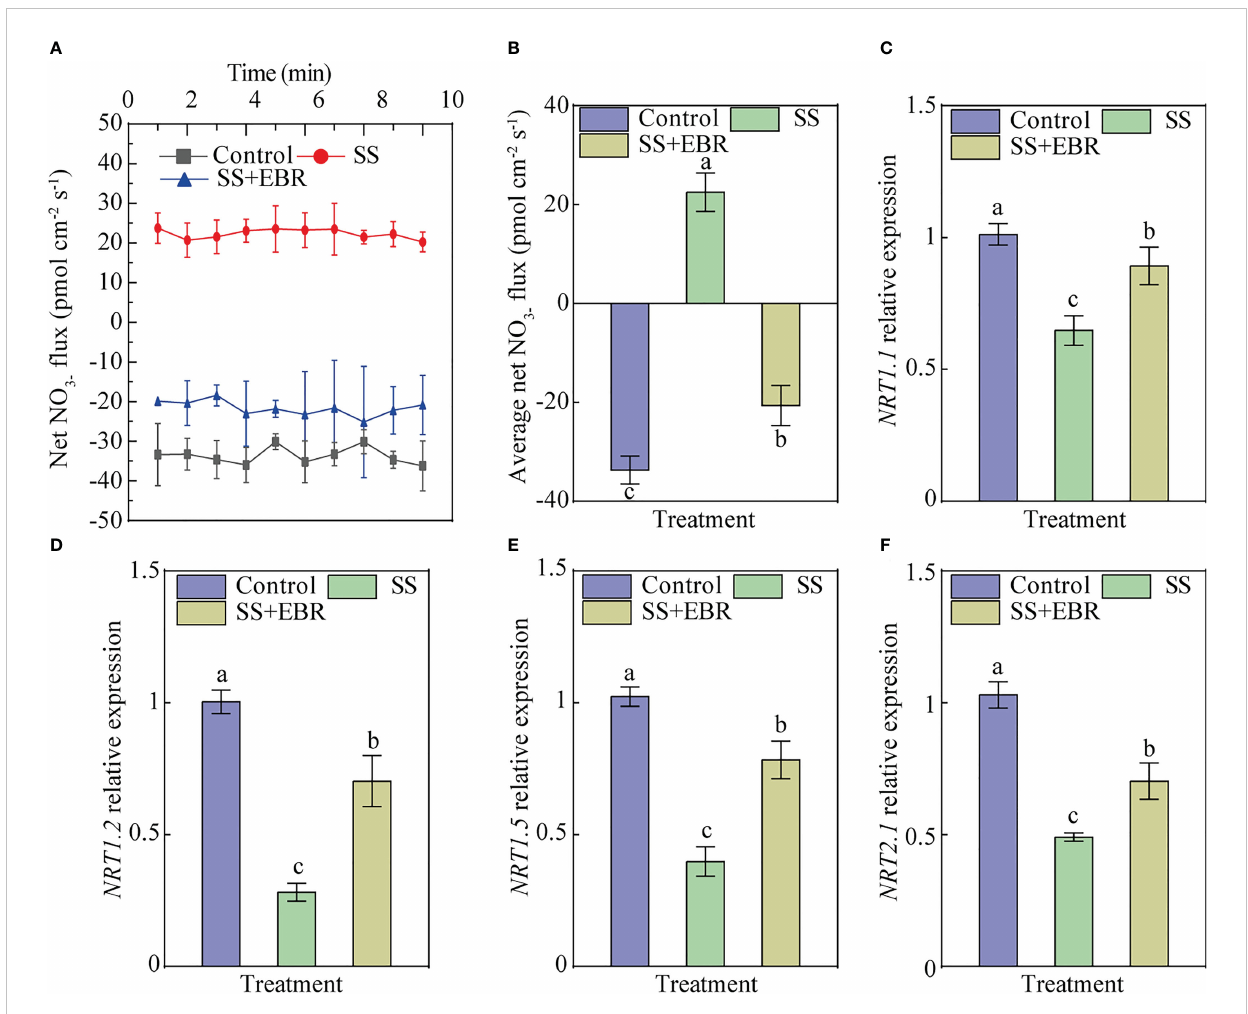
FIGURE 7 Net NO − 3 fl uxes in the roots of the seedlings for a 10-min period (A) , mean rate of NO − 3 fl uxes during the entire 10-min period (B) and the expression of the NRT1.1 (C) , NRT1.2 (D) , NRT1.5 (E) and NRT2.1 (F) genes in the roots of seedlings. The error bars represent the SD, and the different letters indicate signi fi cant differences ( P <